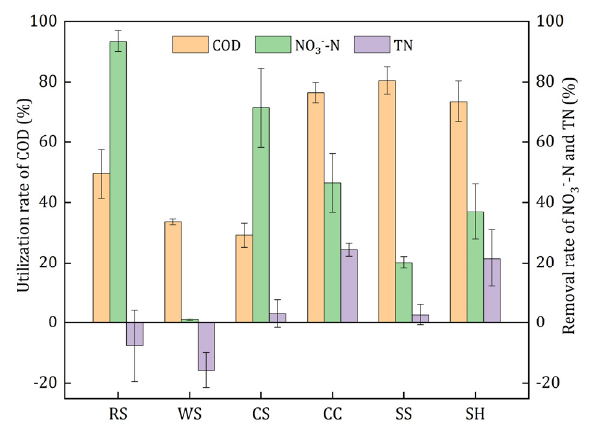
Figure 5. Denitrification performance of leachates of the investigated agricultural wastes.